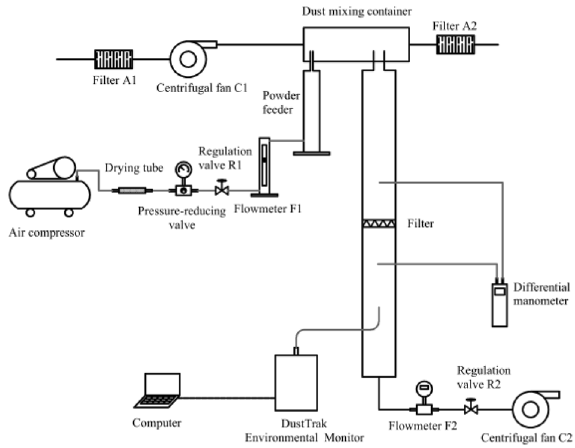
Figure 5. Schematic diagram of the experimental system.